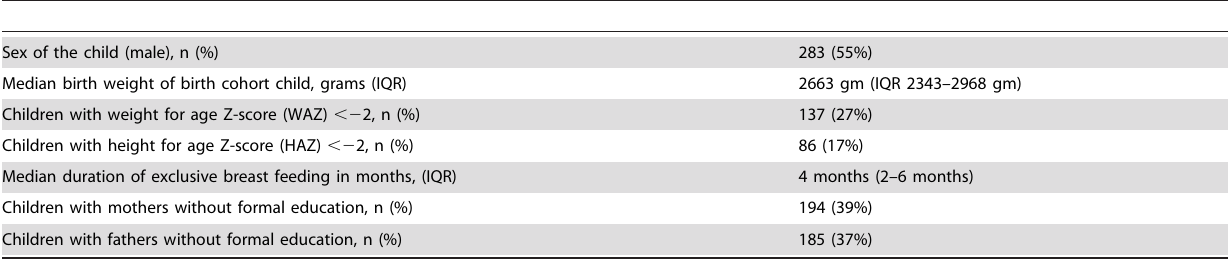
Table 1. Baseline information of a cohort children (n=515) in urban low income neighborhood of Dhaka, Bangladesh during April 2009–March 2011.